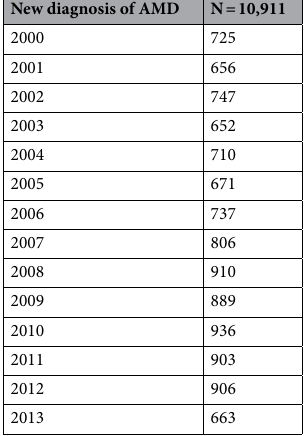
Table 1. Enrollment of AMD cases by year. AMD age-related macular degeneration.